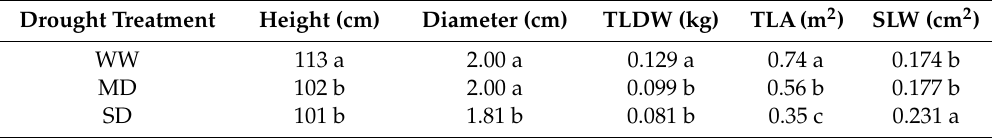
Figure 2. Daily trends of photosynthetic rate (PS) and stomatal conductance (g s ) in loquat plants under well-watered conditions (WW), mild drought (MD) and severe drought (SD) on 29 May (( A ) and ( C )) and 26 July (( B ) and ( D )). Error bars represent standard errors of means. Significance level from analysis of variance: n.s., non-significant; **, significant at P < 0.001. When present, di ff erent letters indicate significant di ff erences among irrigation treatments for a specific date (Tukey’s multiple range test, p < 0.05). Table 1. Final height, main stem diameter, total leaf dry weight (TLDW), total leaf area (TLA), and specific leaf weight (SLW) in loquat plants under well-watered conditions (WW), mild drought (MD) and severe drought (SD) Within each column, di ff erent letters indicate significantly di ff erent means by Tukey’s multiple range test ( p <